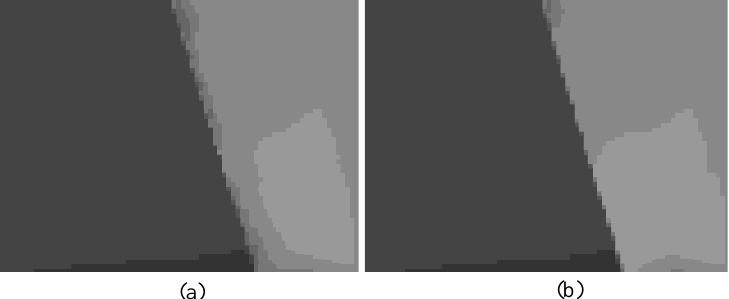
Figure 14. Visual comparison: ( a ) without the directional Gaussian kernel; ( b ) with the directional Gaussian kernel.